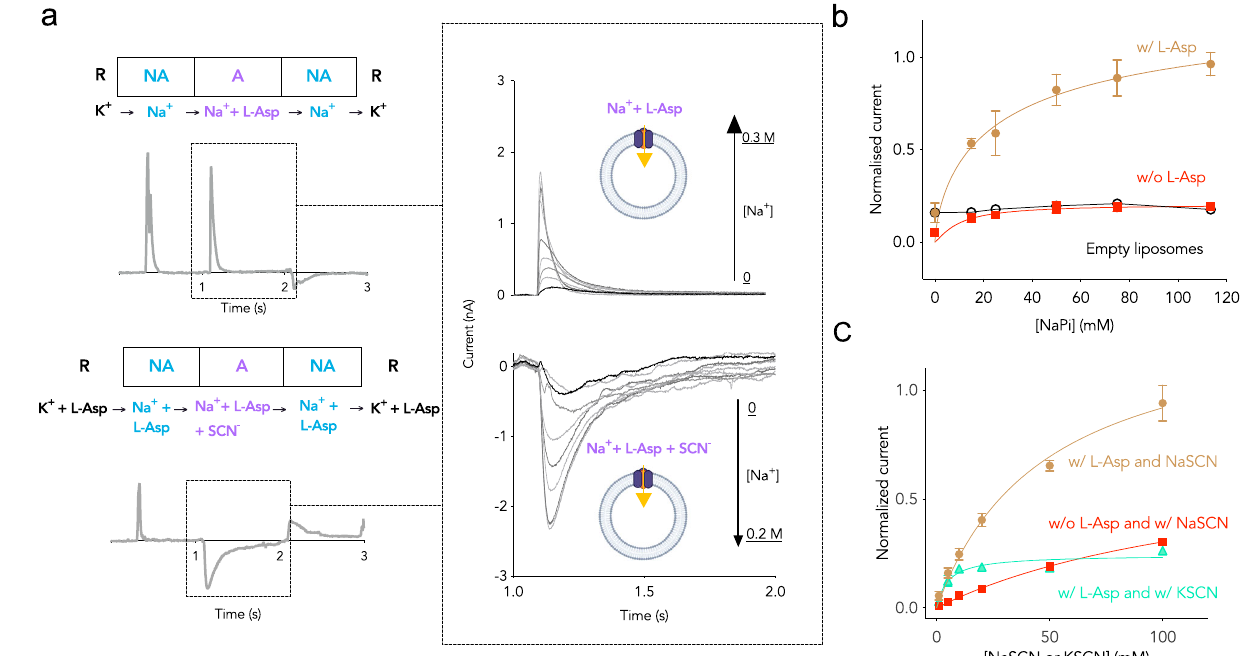
Fig. 2 | Electrogenic transport activity and substrate dependence of the anion conductance in wild type Glt Tk . a Top, Left: fl ow scheme of current amplitude measurement upon L-Asp jump. Top Middle: Progressive increase of the current amplitude upon L-Asp jump in the presence of increasing concentrations of Na + in the activating buffer. a Bottom, Left: fl ow scheme of current amplitude measure- mentuponSCN - jump.Progressiveincreaseofthenegativecurrentamplitudeupon SCN - jump in the presence of increasing concentrations of Na + in the activating buffer. Details of the buffer exchanges are reported in the main text and the full tracesareshowninSupplementaryFig.3)( b )Na + dependenceoftheSCN - currents in the presence or absence of L-Asp measured on wild type Glt Tk . For the experi- mentinthepresenceofL-Asp(brown)eachpointwascalculatedaveragingthedata fromthreetechnicalreplicatesandthennormaliseddividingeachaveragedcurrent by the maximum amplitude (I/I max ). For the experiment in the absence of L-Asp (red), each point was calculated averaging the data from three technical replicates